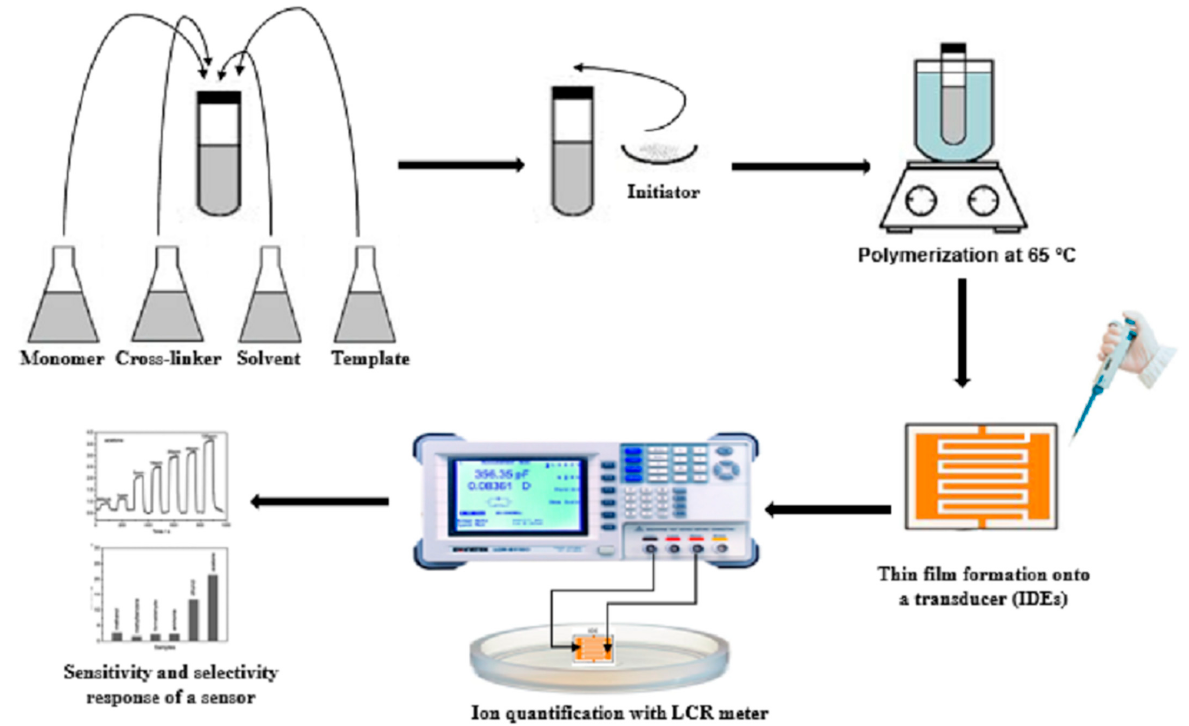
Figure 1. Artificial receptors synthesis and sensor setup